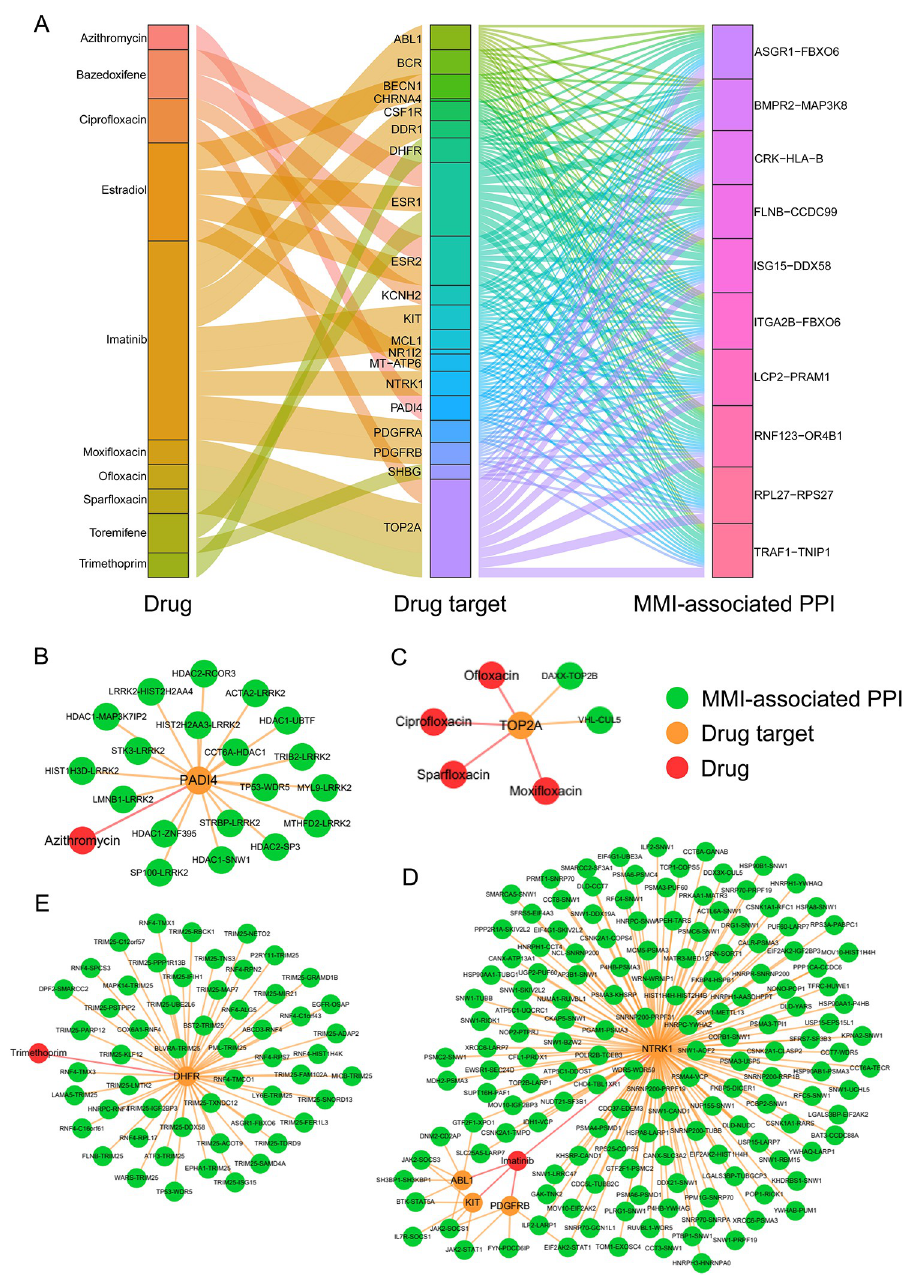
Fig 11. Drug-target-PPI associations for MMI. (A) Relationship between anti-MMI drug candidates and MMI- associated PPIs. Top 10 PPIs with the highest number of shortest links to drug targets are shown (one PPI may correspond to multiple targets). (B) Closest PPIs regulated by azithromycin. (C) Closest PPIs regulated by ciprofloxacin, moxifloxacin, ofloxacin and sparfloxacin. (D) Closest PPIs regulated by imatinib. (E) Closest PPIs regulated by